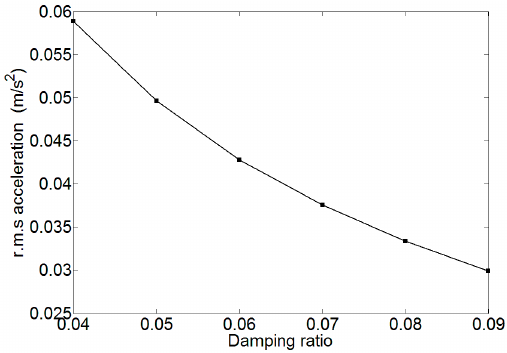
Figure 11. The influence of the damping ratio.